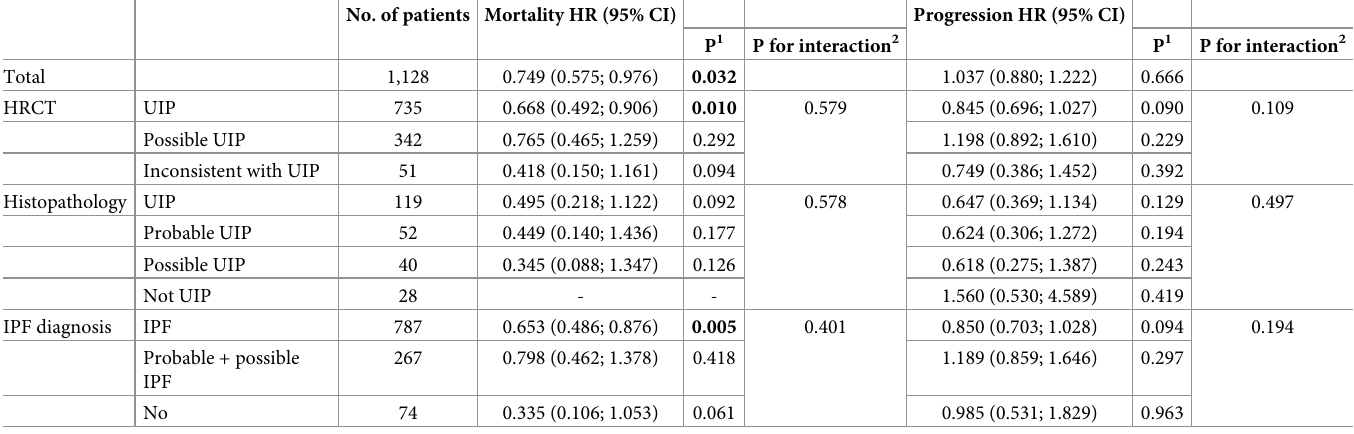
Table 2. Hazard ratios associated with mortality and progression of IPF comparing pirfenidone with no antifibrotic treatment according to diagnostic subgroups (adjusted for age, sex, height, NYHA and FVC at baseline). No. of patients Mortality HR (95% CI)